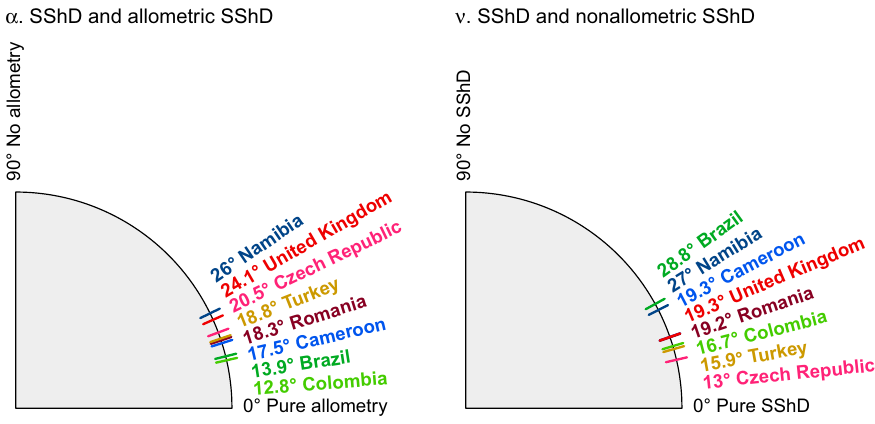
Figure 3. Angles between total SShD vector separating male and female means and its allometric (α) and non- allometric components